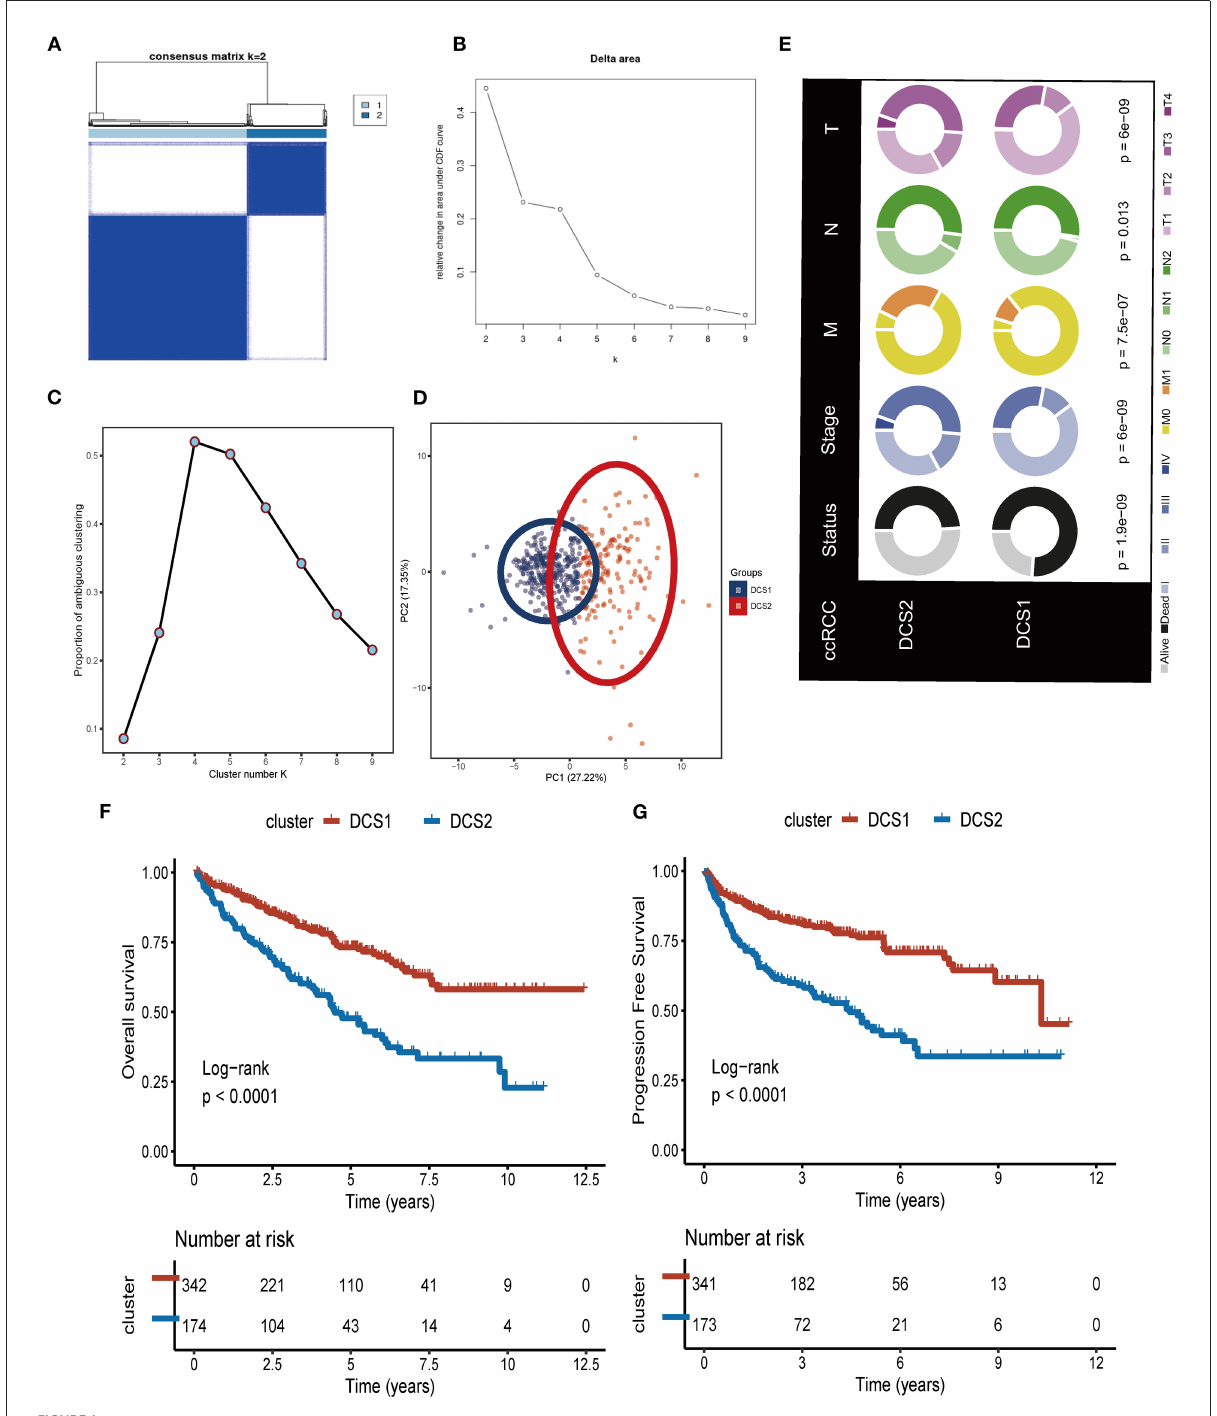
FIGURE1 Identification of two DDR related subtypes. (A) Consensus cluster matrix based on DDR-related regulators. (B) Relative change in area under cumulative distribution function (CDF) curve. (C) The proportion of ambiguous clustering score, and the optimal cluster number. (D) Two-dimensional principal component plot based on DDR related regulators. (E) Clinical difference between DCS1 and DCS2. (F,G) Survival analysis of OS and